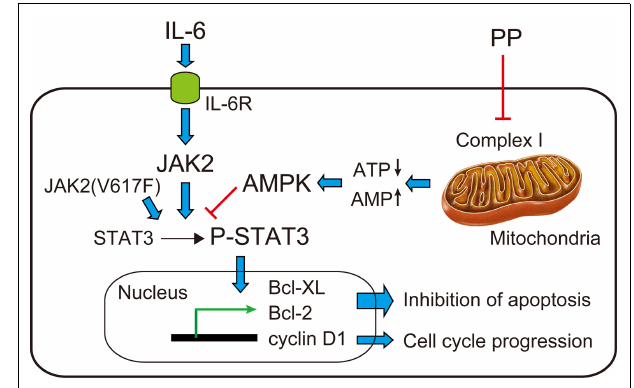
FIGURE 2 | Proposed mechanisms of inhibitory effects of PP on the proliferation of myeloma/erythroleukemia cells. IL-6 binds to its transmembrane receptor (IL-6R) and activates JAK2, which phosphorylates STAT3.Tyr 705 -phosphorylated STAT3 (P-STAT3) translocates to the nucleus and activates transcription of Bcl-XL, Bcl-2, and cyclin D1, thereby inhibiting apoptosis and inducing cell cycle progression of myeloma/erythroleukemia cells. PP inhibits mitochondrial electron-transport chain complex I and activates AMPK to inhibit STAT3-Tyr 705 phosphorylation (Harada etal.,